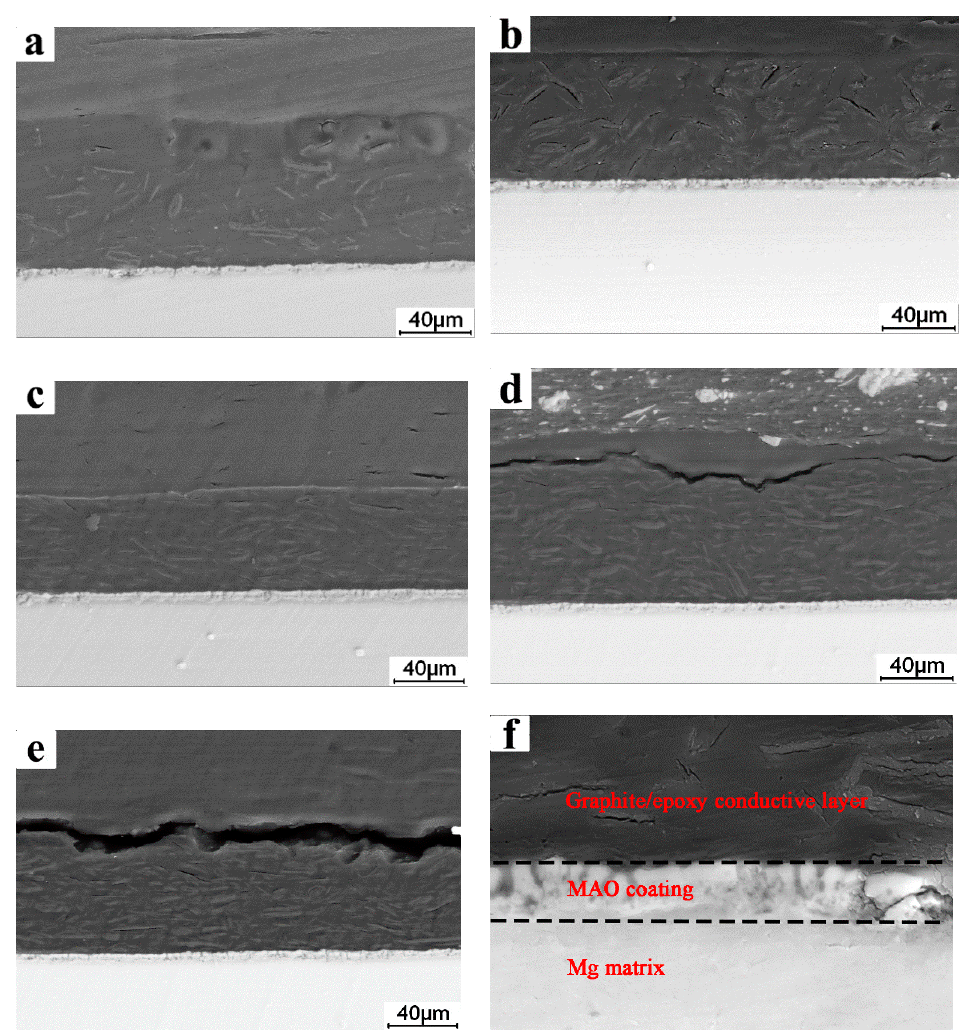
Figure 3. Cross-section morphologies of the graphite-epoxy coatings: ( a ) 20 wt%, ( b ) 40 wt%, ( c ) 60 wt%, ( d ) 80 wt%, ( e ) 100 wt%, and ( f ) coating interface of the Mg, micro-arc oxidation, and graphite/epoxy (3000 ×